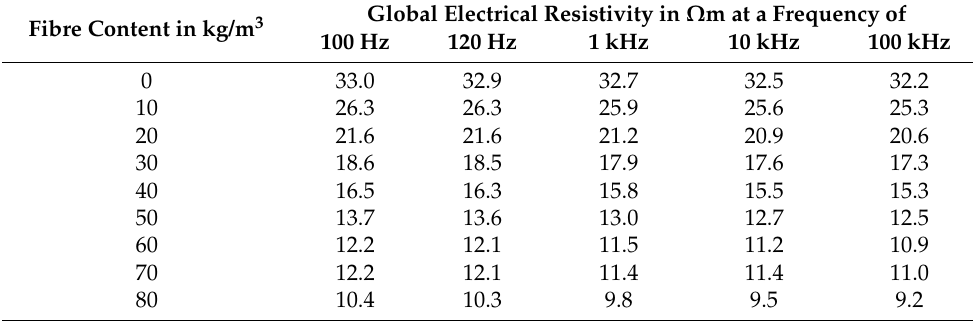
Table A31. Results of the resistivity measurements of the concrete mixture 42-65-300-35.